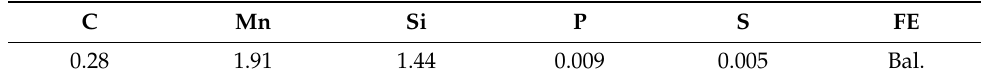
Table 1. Chemical composition,